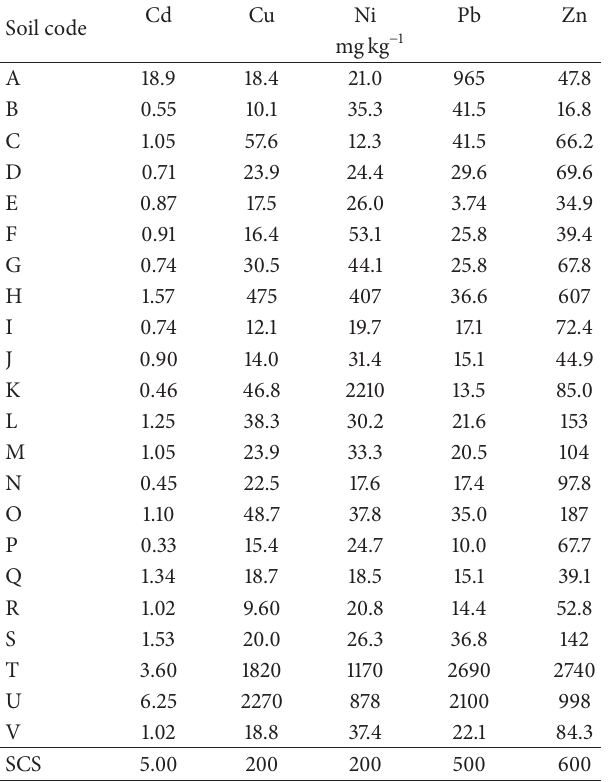
Table 4: Total contents of heavy metals in the studied soils and the soil control standards (SCS) for rural lands in